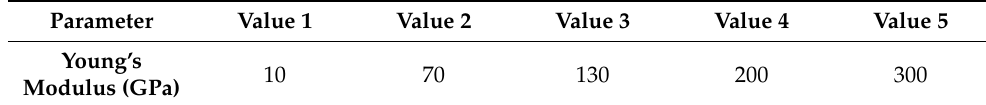
Table 5. Young’s modulus values for the tests.